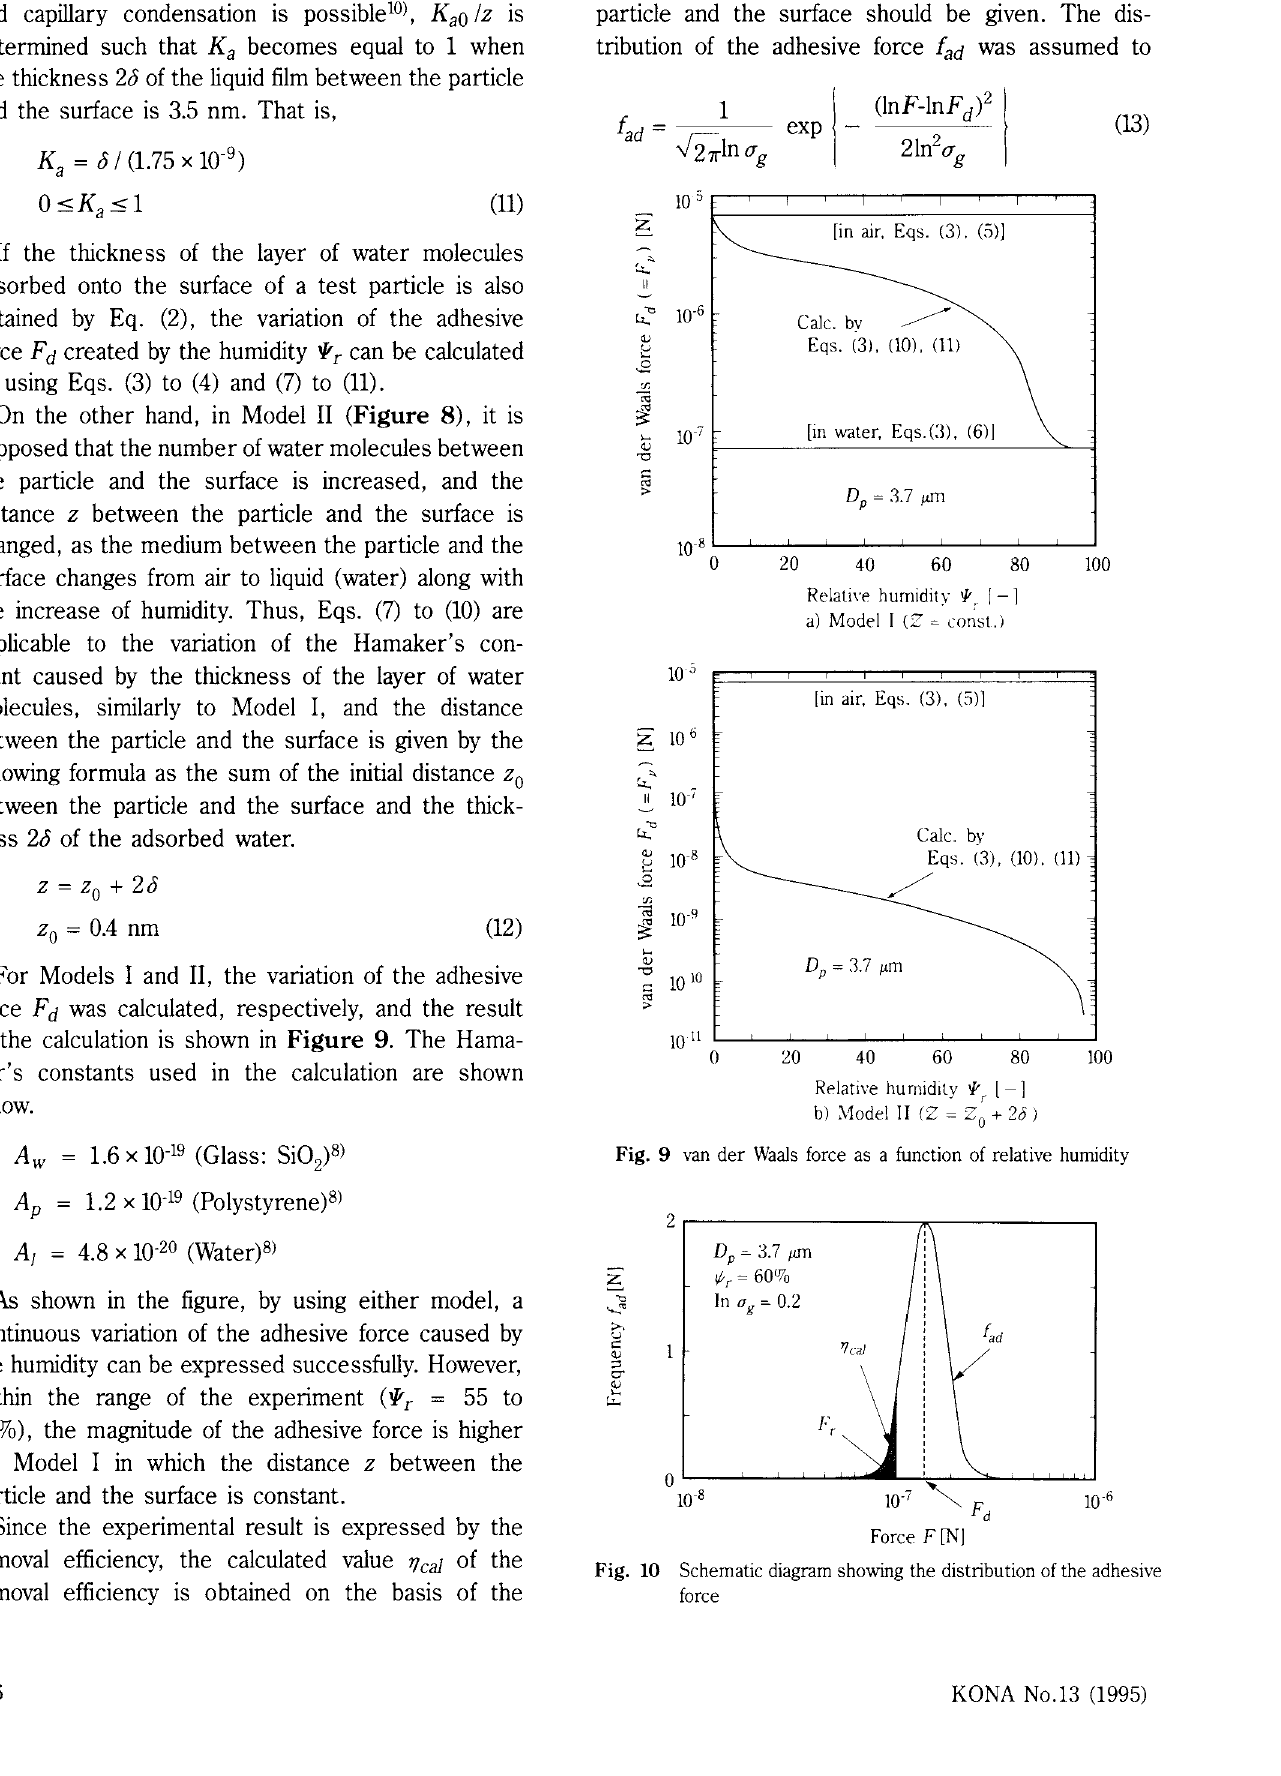
Fig. 10 Schematic diagram showing the distribution of the adhesive force